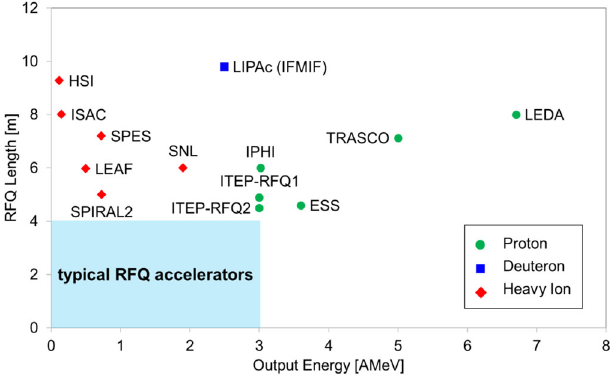
FIG. 1. Overview of some long ( > 4 m) RFQ accelerators constructed or operated worldwide (note: the HSI and SPIRAL2 RFQs are also used for light